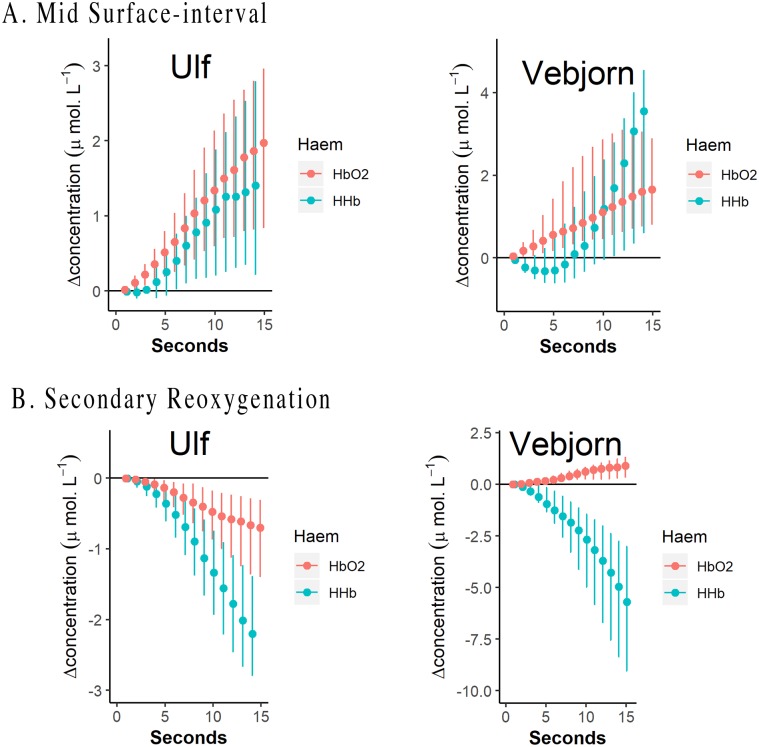
Cerebral haemodynamics (‘Haem’) of O2Hb and HHb for two seals during two key phases of a dive.(A) Mid-surface interval and (B) early in a dive when secondary reoxygenation occurred. Dots represent median concentration change. Error bars represent the interquartile range. Changes are shown as relative changes from CBV minima during a PDSI. Dives by Vebjörn, n = 23. Dives by Ulf, n = 54. Data can be found here: https://doi.org/10.5061/dryad.k67cg66. CBV, cerebral blood volume; HHb, deoxyhaemoglobin; O2Hb, oxyhaemoglobin; PDSI, postdive surface interval.